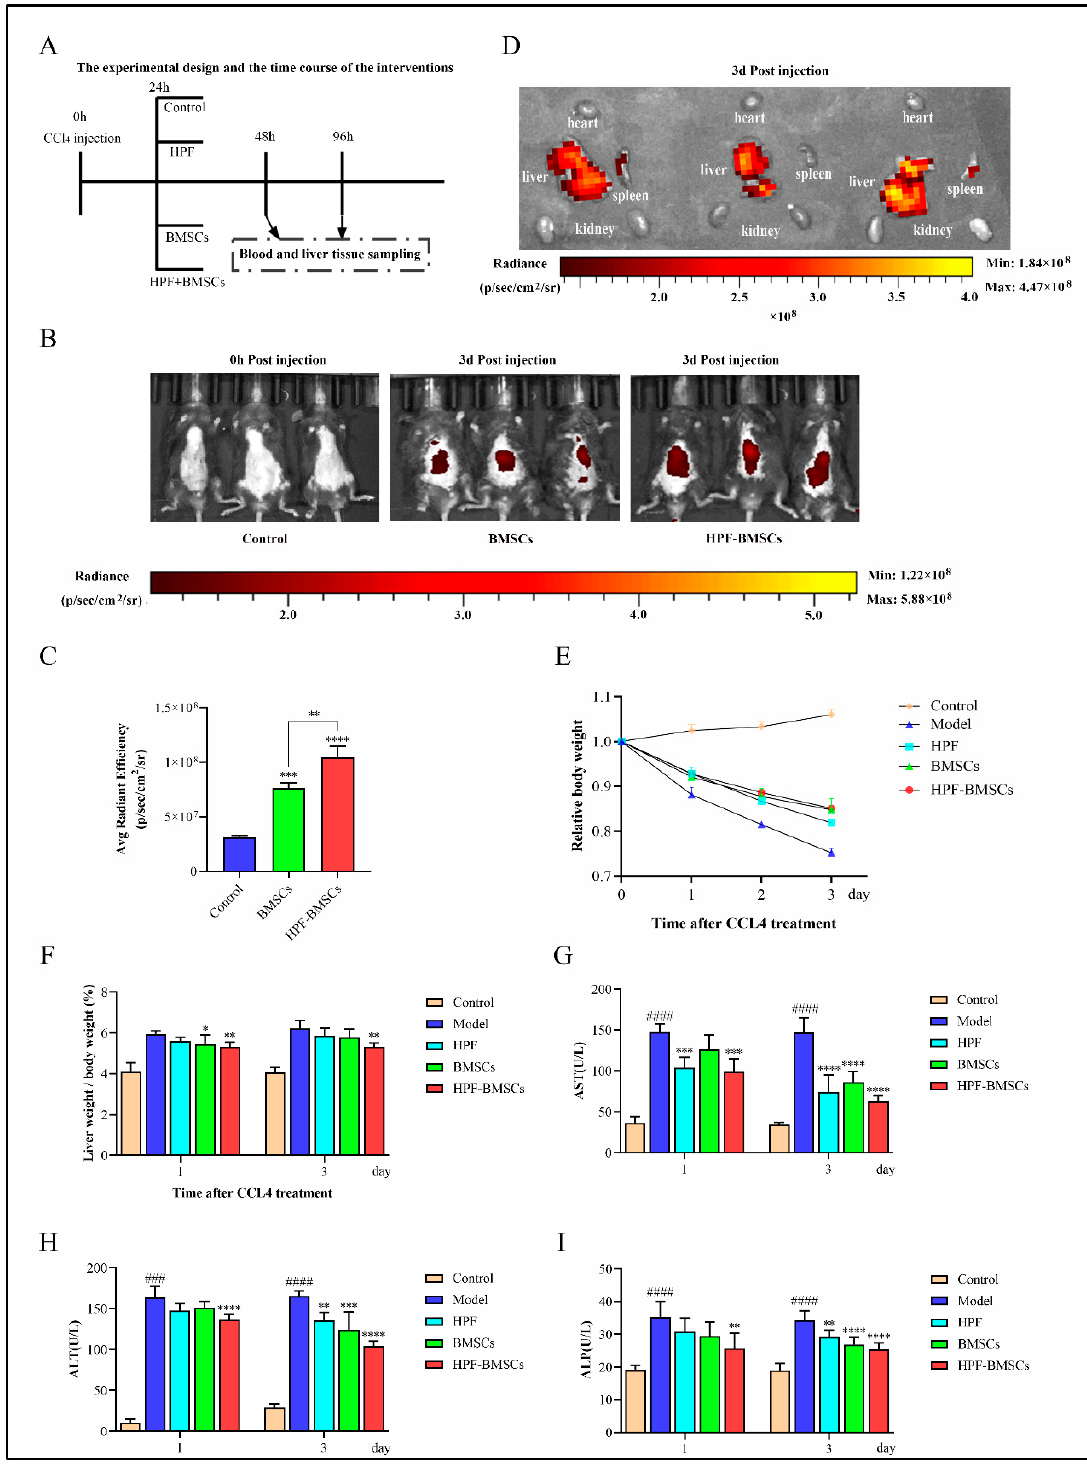
Figure 5. HPF combined with BMSCs improves CCl 4 -induced ALI in mice. ( A ) Time flow chart of experimental design and intervention. ( B ) Fluorescence display of blank control group, BMSC group and HPF–BMSC group on the 3rd day after BMSC injection. ( C ) Statistics of fluorescence intensity, representing BMSCs’ homing to the liver. ( D ) Fluorescence distribution of the HPF–BMSC group in the main organs, on the 3rd day after injection of BMSCs. ( E ) Relative body weight. ( F ) Liver index. Serum levels of ( G ) AST, ( H ) ALT and ( I ) ALP. ### p < 0.001 and #### p < 0.0001 compared with control group, * p < 0.05, ** p < 0.01, *** p < 0.001 and **** p < 0.0001 compared with the model group.